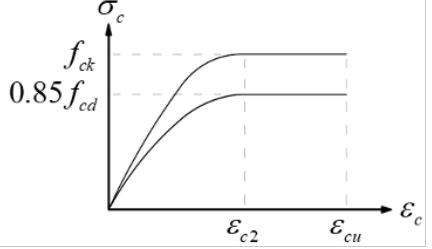
Figure 1. Idealized stress-strain diagram. Source: Adapted from the ABNT NBR 6118: 2014